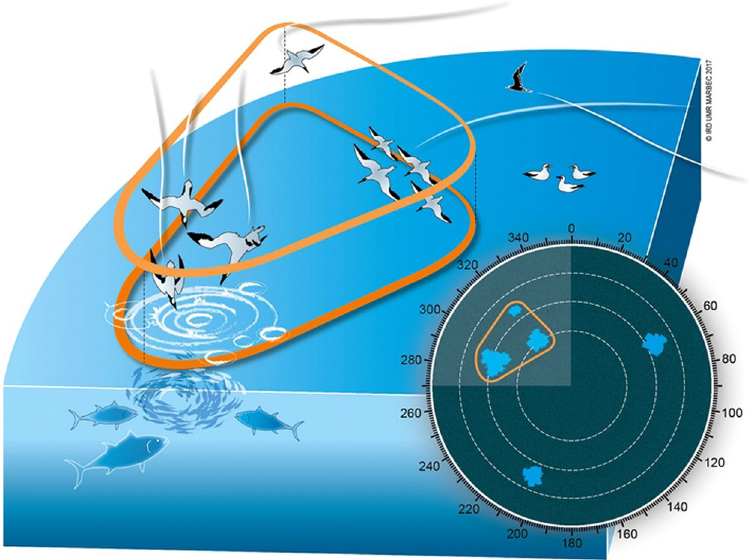
Figure 1. This illustration depicts an hypothetical oceanic scene with different seabirds and its possible appearance in the radar screen. The information relevant to this work are: (1) echoes in the radar can be either one bird or a group of birds foraging or transiting (referred to as “seabird-echoes” or “seabirds groups” in the text); (2) small seabirds and seabirds sitting on the water are unlikely to be detected by the radar; (3) when echoes are spaced such that they appear close together (see how in methods), they form a cluster of echoes (referred to as such in the text). Clusters might then be considered as “groups of seabirds